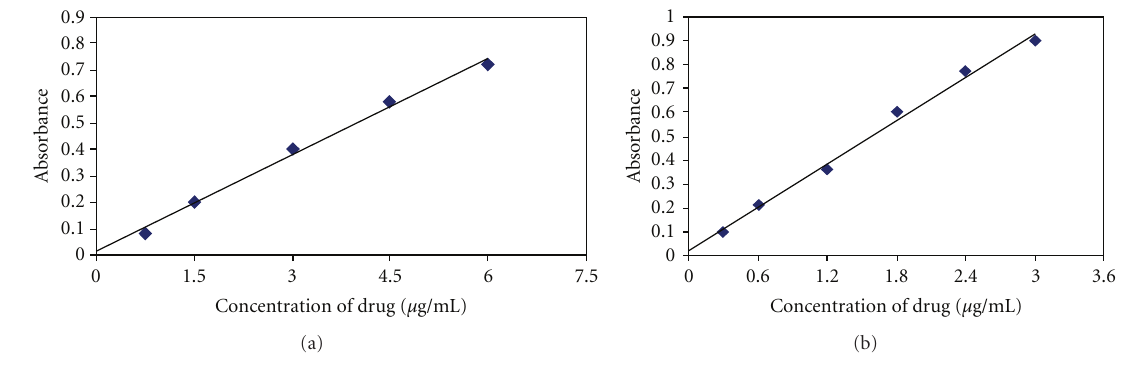
Figure 4: Calibration curves (method C and method